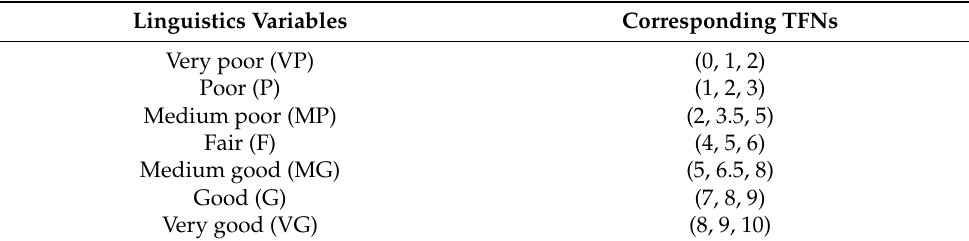
Table 4. Linguistics variable values of alternatives. Linguistics